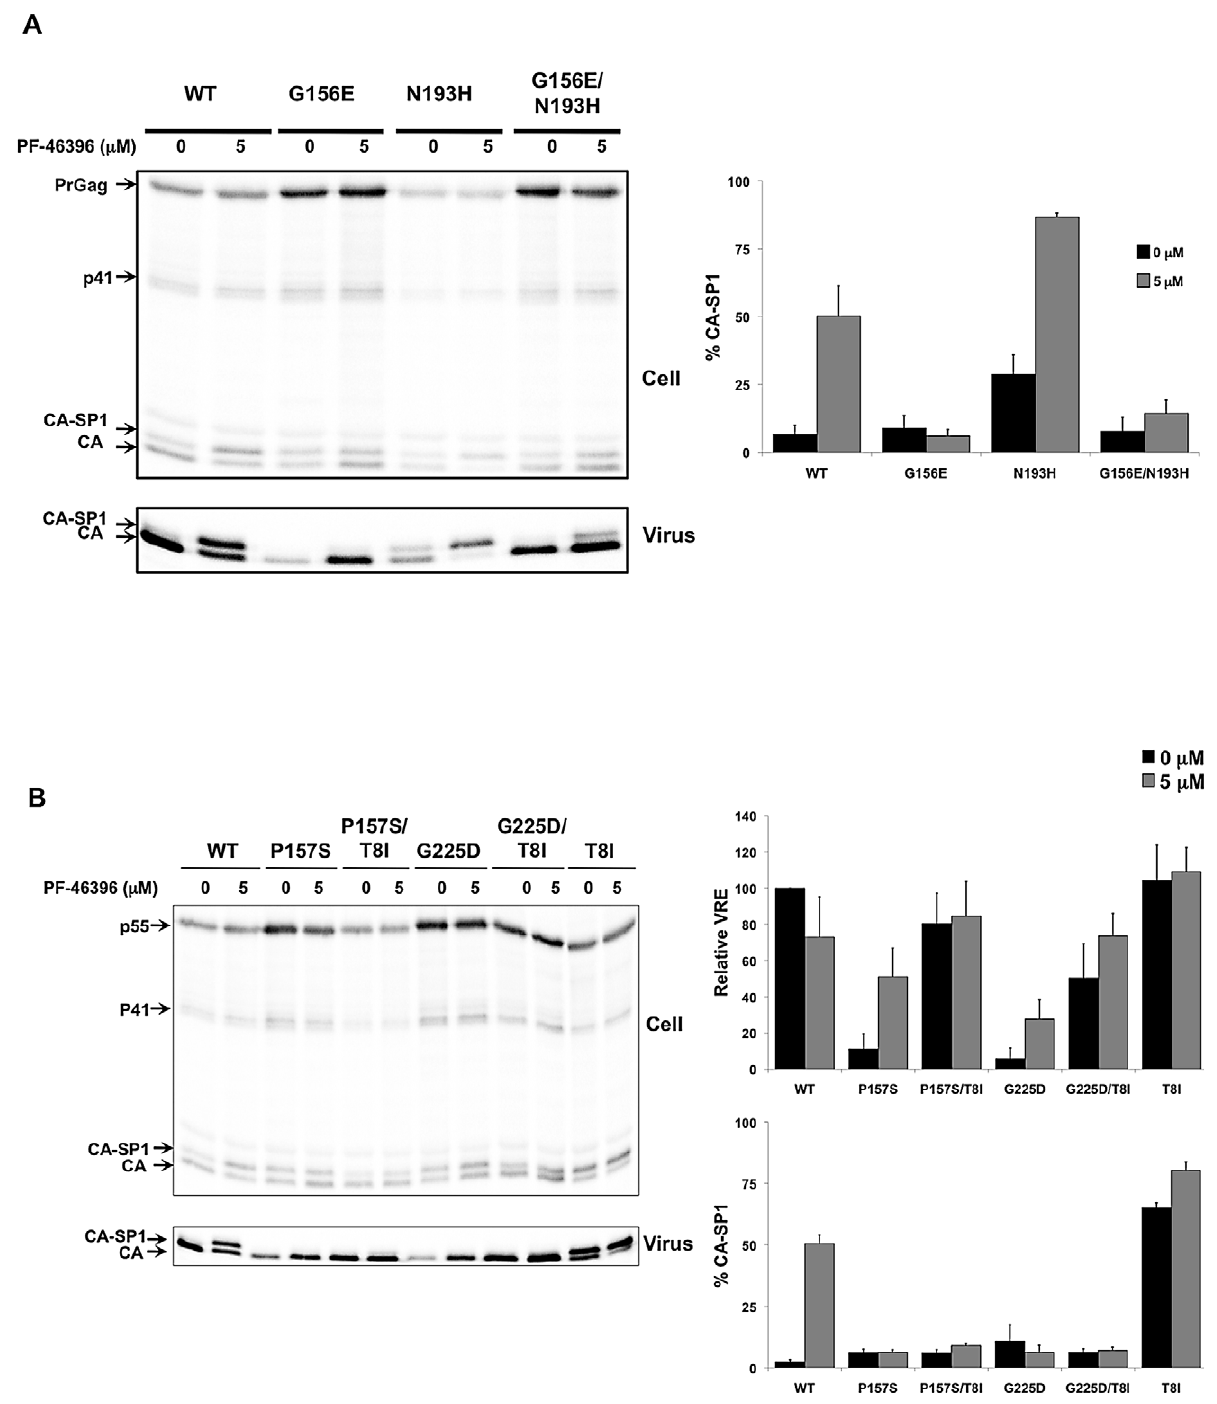
Figure 10. Second-site compensatory changes correct the replication defects exhibited by PF-46396-dependent CA mutants. [A] Radioimmunoprecipitation analysis of cell- and virion-associated proteins in the absence and presence of 5 m M PF-46396. Analysis performed with WT, CA-G156E, CA-N193H, and CA-G156E/N193H. Positions of Pr55 Gag (PrGag), Pr41 Gag (p41), CA-SP1, and CA are indicated. Graph on the right shows phosphorimager-based quantification of the % CA-SP1 relative to total CA + CA-SP1 in virion fraction at the indicated concentration of PF-46396. Error bars denote SD; N=5. [B] Radioimmunoprecipitation analysis of cell- and virion-associated proteins in the absence and presence of 5 m M PF-46396. Analysis performed with WT, CA-G157S, CA-P157S/SP1-T8I, CA-G225D, CA-G225D/SP1-T8I, and SP1-T8I. Positions of Pr55 Gag (PrGag), Pr41 Gag (p41), CA-SP1, and CA are indicated. Graphs on the right show phosphorimager-based quantification of relative virus release efficiency (VRE) and % virion CA-SP1, calculated as described in the Fig. 6 legend. Error bars denote SD; N=3.